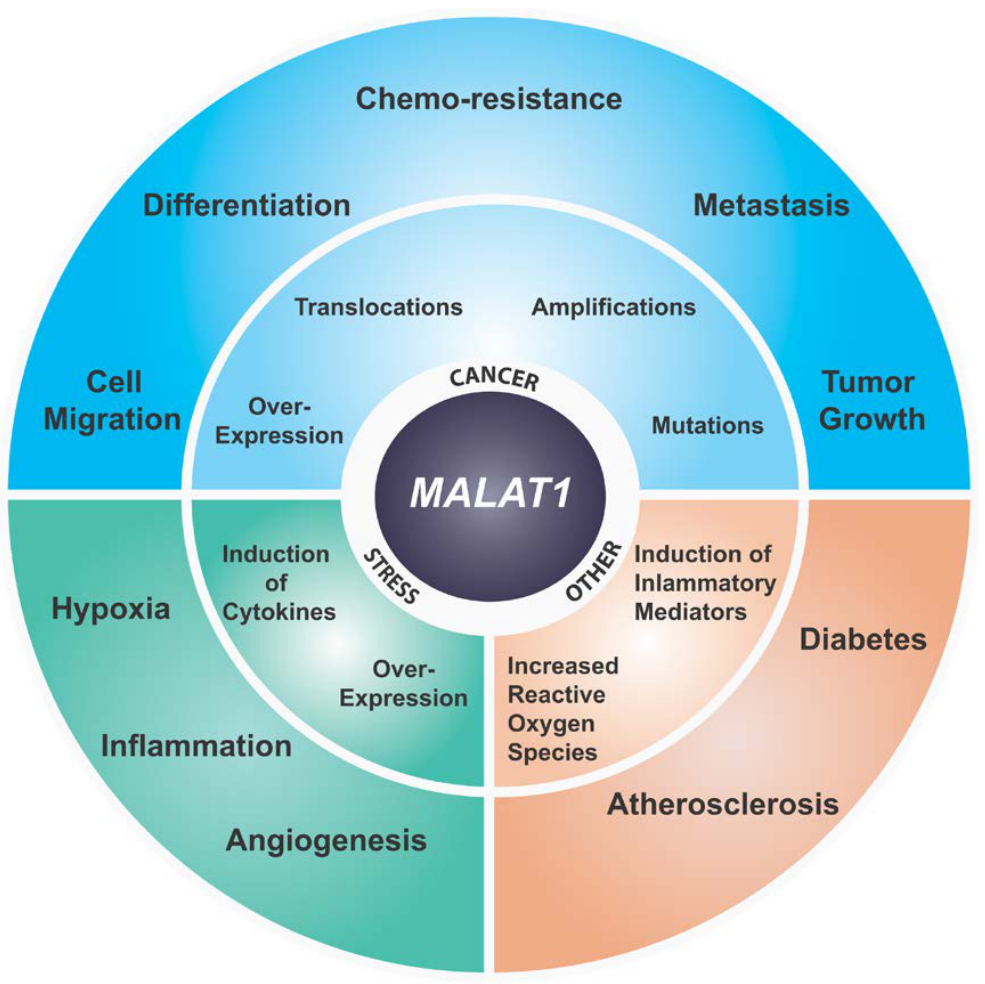
Figure 2. Summary of known disease implications of MALAT1 .